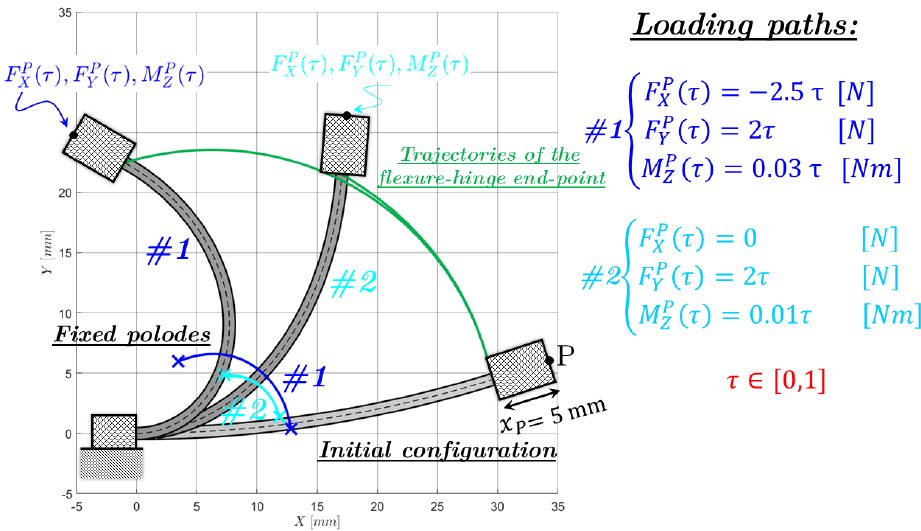
Figure 7. Flexure-hinge loaded by two different loading paths.